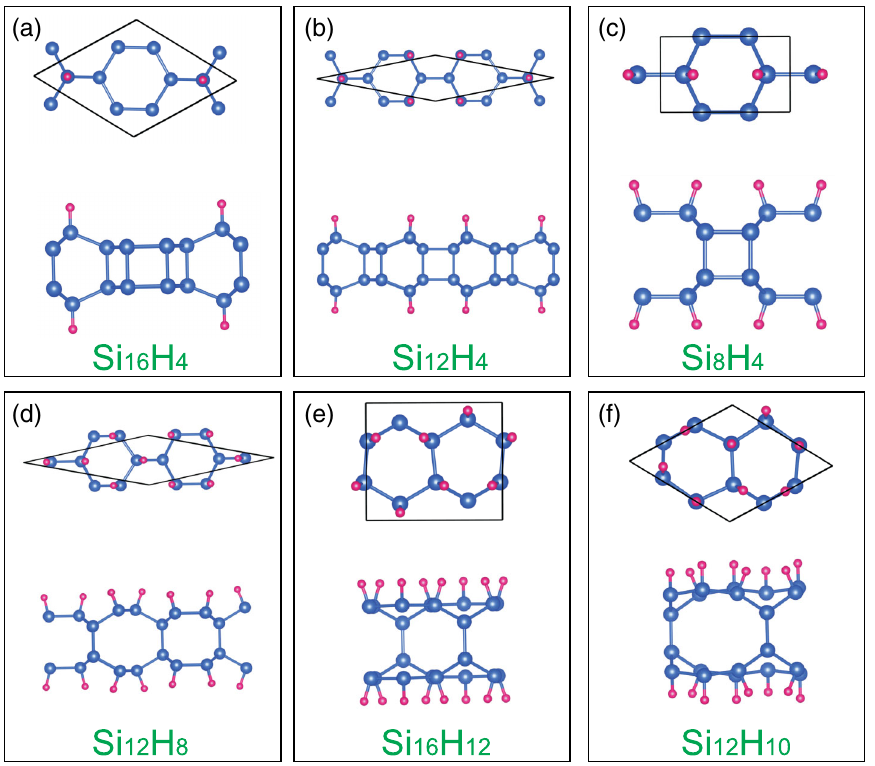
FIG. 4. The top and side views of six CE-discovered intermediate ground-state structures for double-sided (a) Si 16 H 4 , (b) Si 12 H 4 , (c) Si 8 H 4 , (d) Si 12 H 8 , (e) Si 16 H 12 , and (f) Si 12 H 10